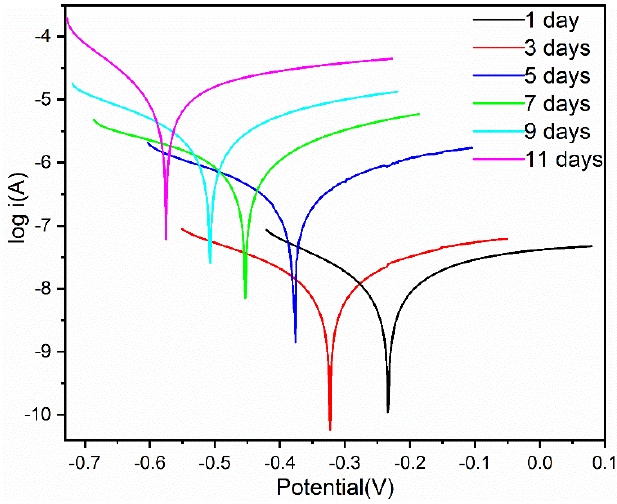
Table 1. Tafel parameters of CPEEUA/FS-40 nanocomposite.